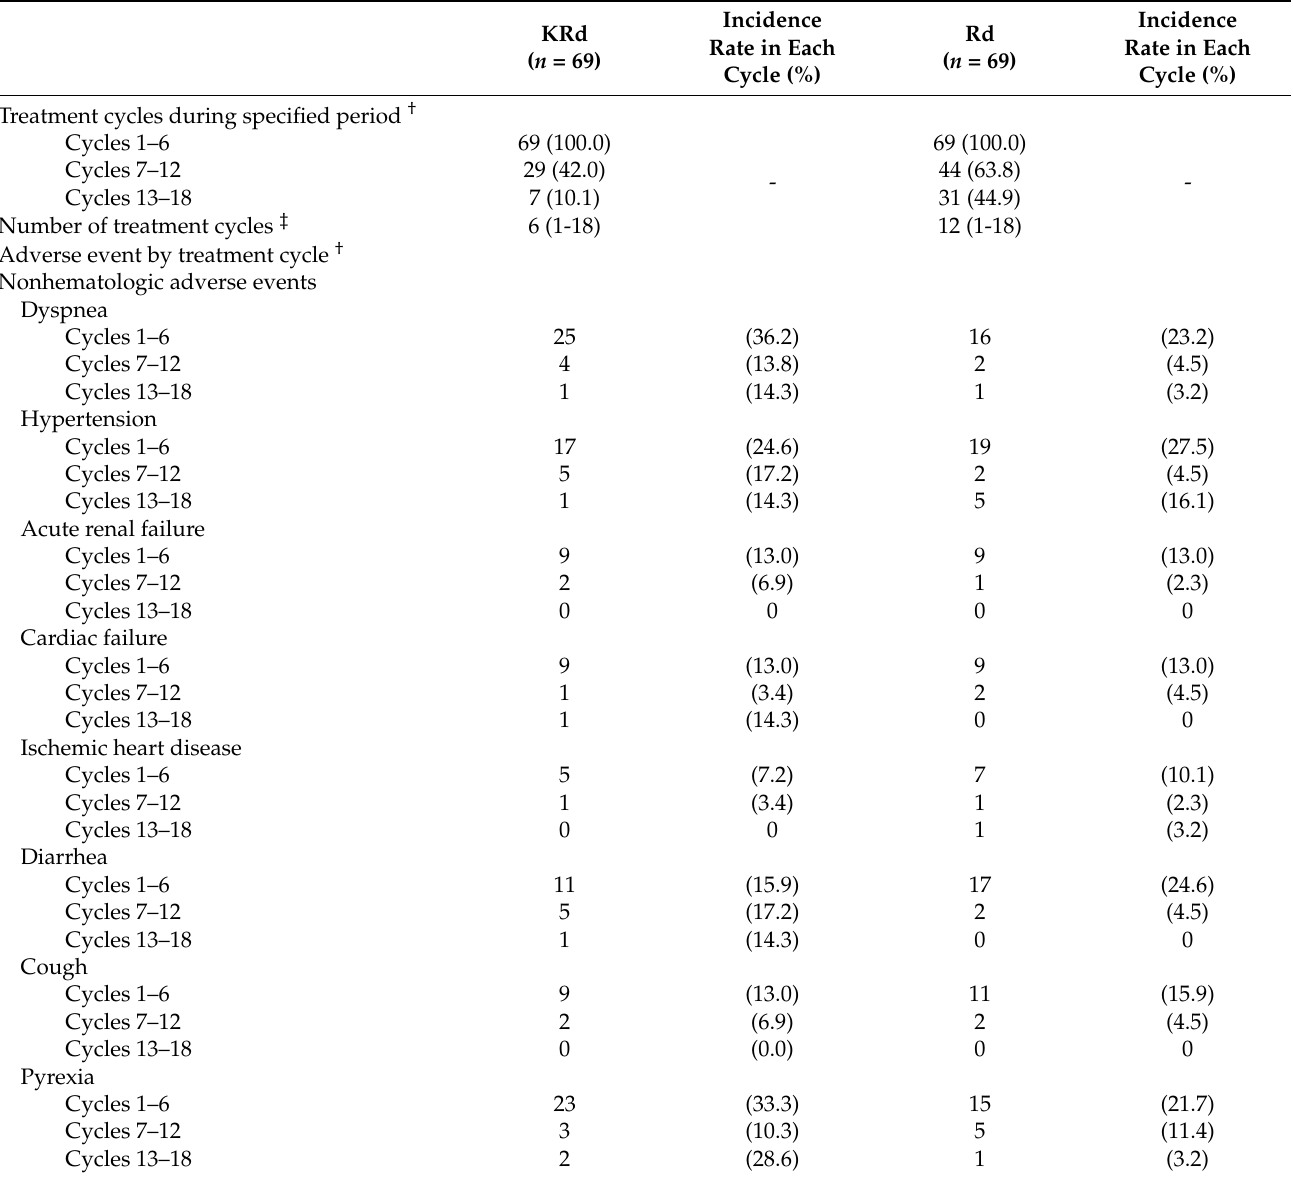
Table 2. Incidence of adverse reactions by treatment